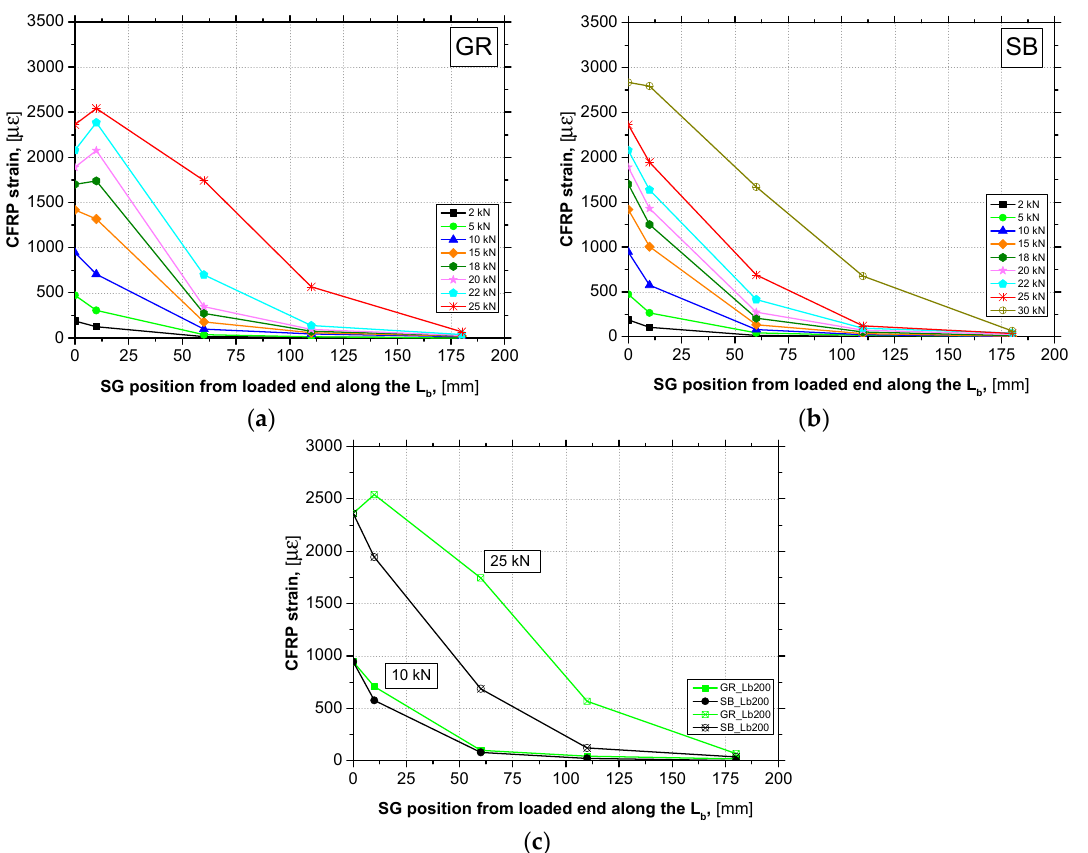
Figure 10. Longitudinal strains at different loading levels along the CFRP: ( a ) GR_Lb200; ( b ) SB_Lb200; ( c ) GR_Lb200 vs. SB_Lb200.